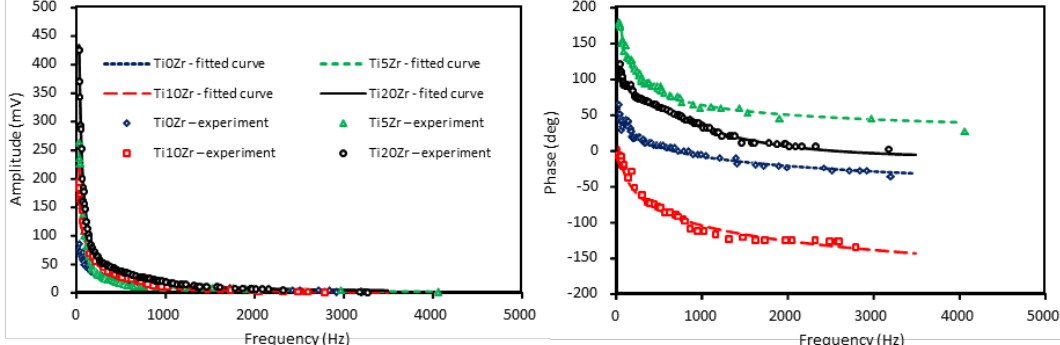
Figure 4. The amplitude ( left ) and phase of BDS signal ( right ) for unmodified and Zr-modified composite samples. Points represent the experimental data whereas continuous lines the best fitting using model presented in [47].